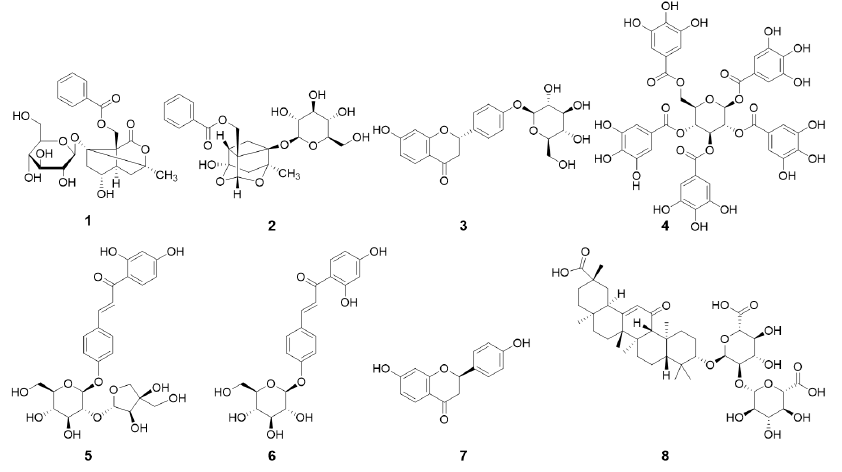
Figure 1. Chemical structures of Jakyakgamcho-tang (JGT) components: albiflorin (1), paeoniflorin (2), liquiritin (3), pentagalloylglucose (4), isoliquiritin apioside (5), isoliquiritin (6), liquiritigenin (7), and glycyrrhizin (8).